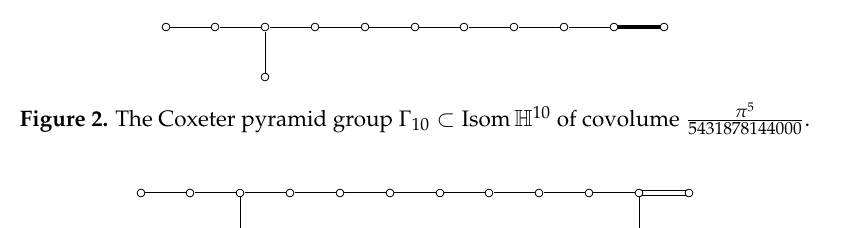
Figure 3. The Coxeter pyramid group Γ 12 ⊂ Isom H 12 of covolume 691 π 6